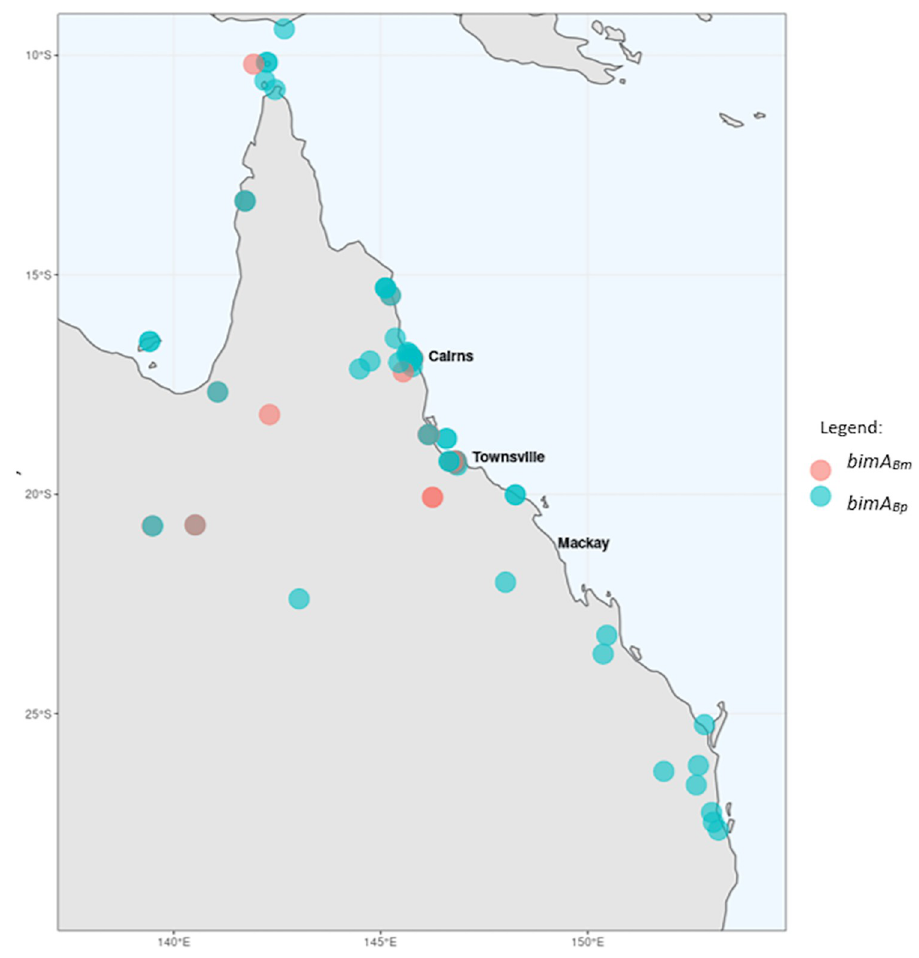
Fig 1. Distribution of B . pseudomallei isolates with the bimA using the rnaturalearth package in R: https://cran.r-project.org/web/packages/rnaturalearth/README.html).